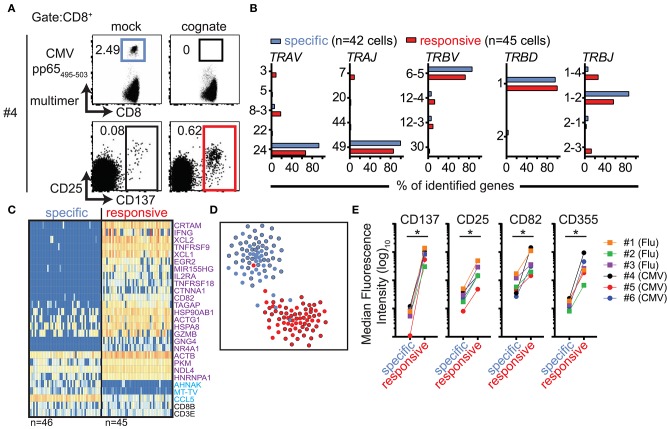
CD137 expression marks antigen-responsive CD8+ T cells in the absence of multimer staining. (A) Representative flow cytometry dot plots of PBMCs from donor #4 stained with HLA-A2 multimers loaded with CMVpp65495−503 peptide after incubating PBMCs for 20 h with mock (Flu MP58−66) or cognate (CMVpp65495−503) peptides (top) and corresponding plots showing CD25 and CD137 expression (bottom). All plots show 5 × 104 cells in the CD8 gate. (B) TCR repertoire analysis of CD8+ T cells subjected to single-cell sorting based on positive staining with CMVpp65495−503 peptide-loaded HLA-A2 multimers from PBMCs stimulated with mock peptide (blue gate in A; antigen-specific) or based on CD137 expression after incubation with cognate peptide (representing cells in the red gate in A; antigen-responsive). The frequencies of genes used for the production of TCR α and β chains in each of the two populations of cells are shown. (C) Heatmaps of the top 25 ranked differentially expressed genes in CMV pp65495−503-specific relative to CMV pp65495−503-responsive CD8+ T cells from donor #4. The numbers of analyzed single cells are shown beneath the heatmaps. (D) t-SNE plot of gene expression data for single-cell-sorted antigen-specific (black outline filled blue) and antigen-responsive CD8+ T cells (black outline filled red). Data for CMV-directed cells incubated with mock (blue) or cognate (red) peptide in the dye-based activation assay are included as a reference. (E) Scatter plots of flow cytometric analyses comparing the median fluorescence intensities for the indicated surface markers between antigen-specific and antigen-responsive CD8+ T cells for donors #1–3 (donors with Flu-directed cells) and #4–6 (donors with CMV-directed cells).